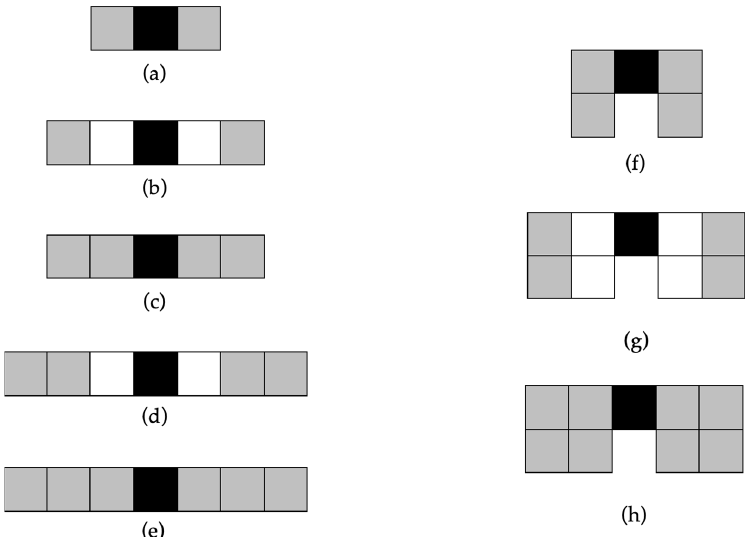
Figure 4. Possible image portions (“search zones”) around an edge pixel; the application of a suitable test condition over a search zone aims at eliminating from a Canny-processed GPR image the edge pixels not lying on hyperbolic reflections. Black squares indicate edge pixels, grey squares are pixels belonging to the search zone, and white squares are other